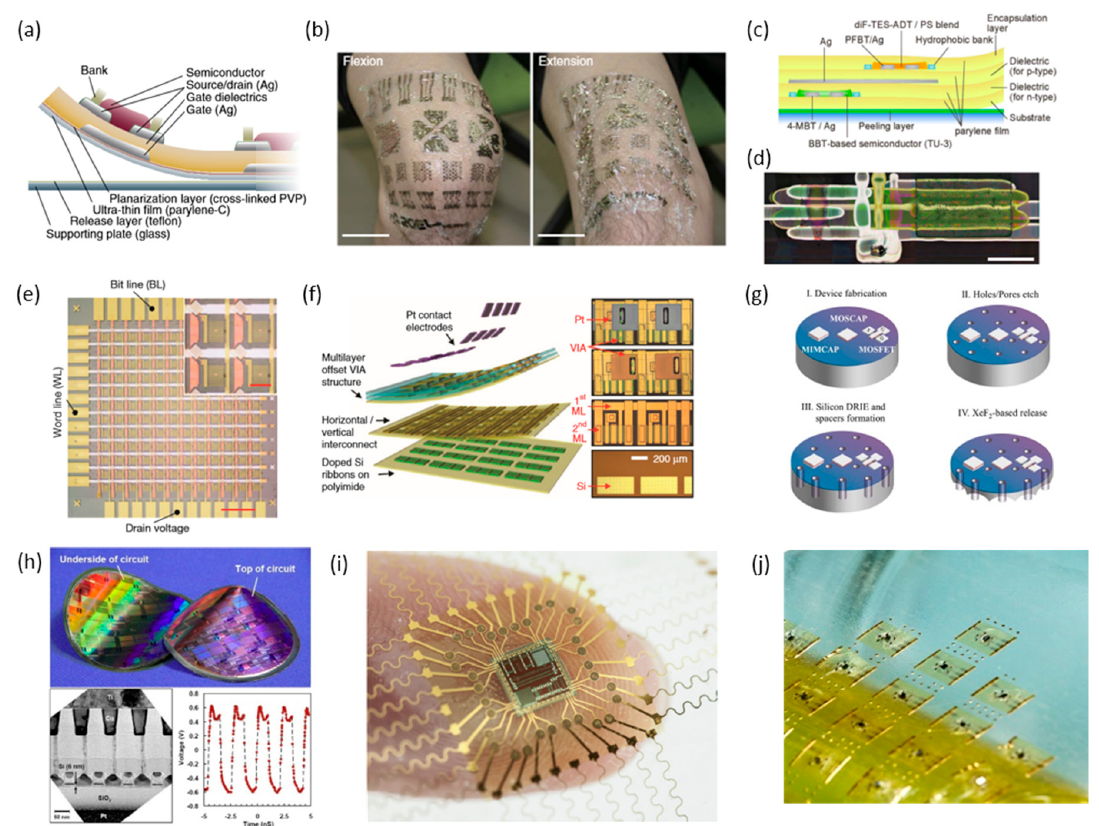
Figure 4. Integration strategies of electronic circuits for FHE. ( a ) Cross-sectional diagram of a fully-printed OTFT (organic thin-film transistors) device and ( b ) application of a thin organic film to a human knee. Scale bar, 4 cm. Reprinted with permission from Macmillan Publishers Ltd.: Nature Communications [164]; ( c ) Cross-sectional diagram and ( d ) photograph of an ultra-thin, fully-printed CMOS logic circuit. Scale bar, 500 µm. Reprint is in accordance with the Creative Commons Attribution 4.0 International License [165]; ( e ) Optical micrograph of a 12 × 12 tactile sensor array utilizing OTFTs as the switching transistors. Scale bar, 1 cm. The inset shows a magnified view of four pixels. Scale bar, 2 mm. Reprinted with permission from Macmillan Publishers Ltd.: Nature [166]; ( f ) Exploded view rendering of the flexible, high-density brain mapping device (left) and respective optical micrographs (right). Reprinted with permission from Macmillan Publishers Ltd.: Nature Communications [168]; ( g ) Process flow of XeF 2 -based Si exfoliation. Reprinted with permission from Reference [173]. Copyright (2014) American Chemical Society; ( h ) Flexible CMOS circuits formed by controlled spalling (top). Cross-section TEM image of the flexible circuit, stressor and handle layers (bottom left). Resulting voltage waveform of a 100 stage ring oscillator (bottom right). Reprint is in accordance with the Creative Commons Attribution 3.0 International License [170]; ( i ) Integration of a thinned die in a flexible substrate. Reprinted from Reference [171], Copyright (2015), with permission from Elsevier; ( j ) Scaled production of soft-adhesive electronics with surface mount chip